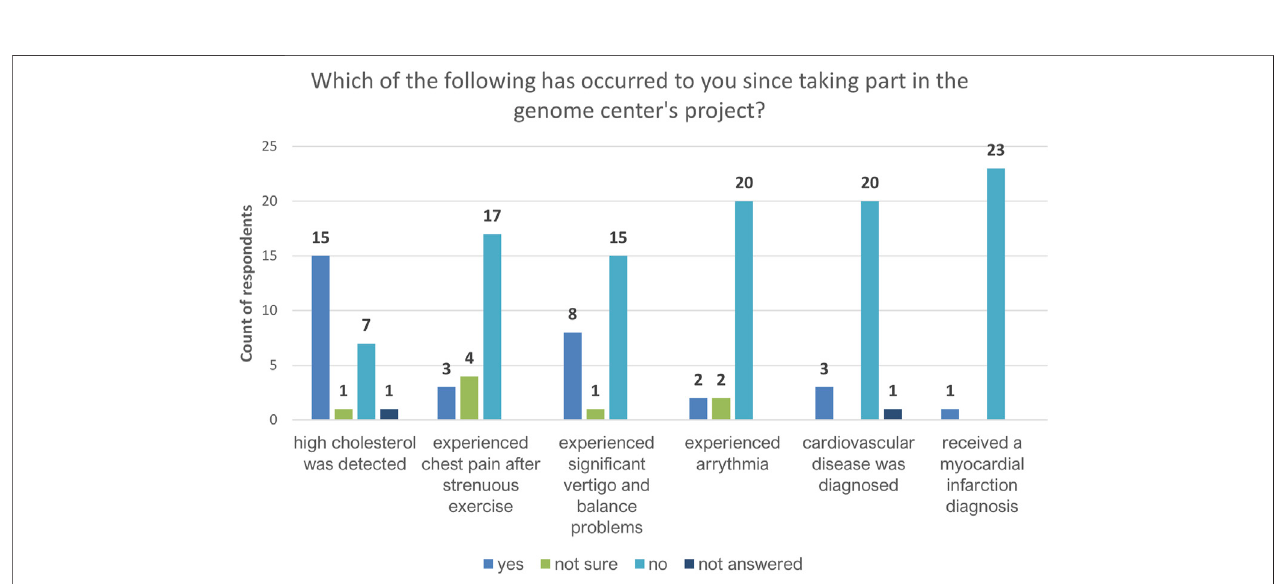
FIGURE 5 | Feedback on health issues potentially related to hypercholesterolemia as reported by recalled participants ( n = 24).